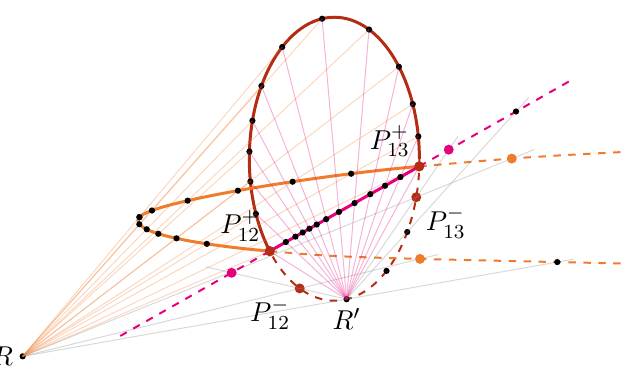
) of the generalized simplex for different rationalizations. Figure 12 . Images of a 1 -face ( P + P + 12 13 With (4.19) and U = P + we use points on P + to parameterize the CP 2 space of projection P + P + i 12 13 14 1 i lines. The red path refers to the 1 -face, and the corresponding dashed circle denotes the curve where this path is restricted to, which is the intersection Q ∩ V . The orange path denotes the image 1 V 2 V 3 of this 1 -face in the rationalization with a generic reference R ∈ Q . The magenta path denotes the image when the reference is chosen as R 0 ∈ Q ∩ V 1 V 2 V 3